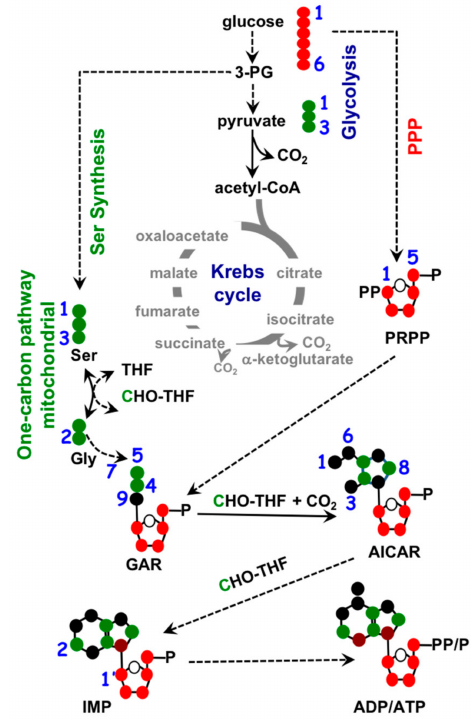
Figure 3. Biochemistry of purine nucleotide synthesis. Ribose base biosynthesis comes from pentose phosphate pathway (PPP) in the cytosol, mitochondrial 1-carbon metabolism contributes to purine ring biosynthesis through 5-methyltetrahydrofolate (CHO-THF). • : Possible cytosolic-derived carbons, • : Possible mitochondrial-derived